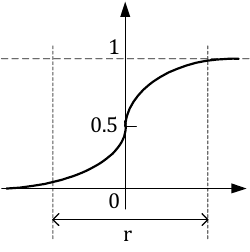
Figure 3. S ‐ type activation transfer function and its adopted range. Figure 3. S-type activation transfer function and its adopted range.